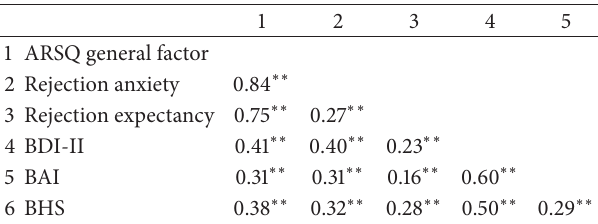
Table 5: Correlations between measures ( 𝑁 = 772